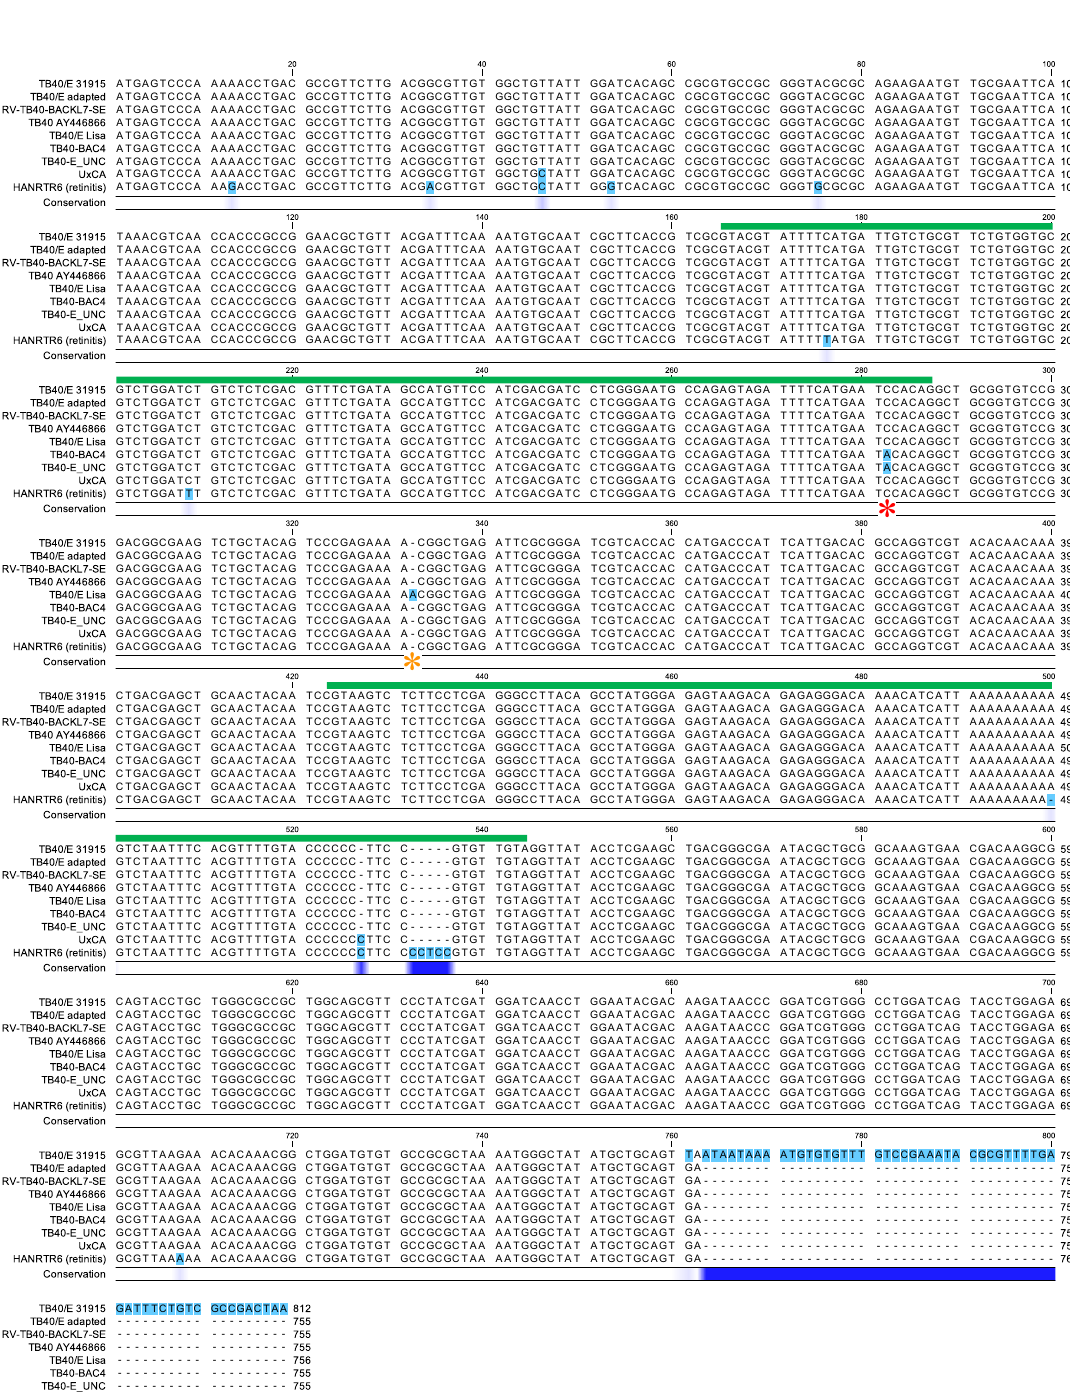
Figure 2. UL128 nucleotide sequence alignment. The UL128-131A region in TB40 / E 31915 and in the SA, SD2, SE2, CB, CD2 and CE2 stock genomes was amplified by polymerase chain reaction (PCR) prior to Sanger sequencing of the UL128 open reading frame (ORF). All adapted strains shared the same UL128 sequence and are thus shown as “TB40 / E adapted”. Sequences were aligned to those found in the listed strains using the CLC Sequence Viewer software. Di ff erent residues are highlighted in turquoise. The degree of conservation amongst the nine sequences is shown by the intensity of the blue color in the Conservation ribbon below the alignment. The green lines denote the ORF introns. The red asterisk marks the C 282 > A transversion exclusive to the TB40-BAC4 strain. The orange asterisk marks the A 332 insertion exclusive to the TB40E-Lisa